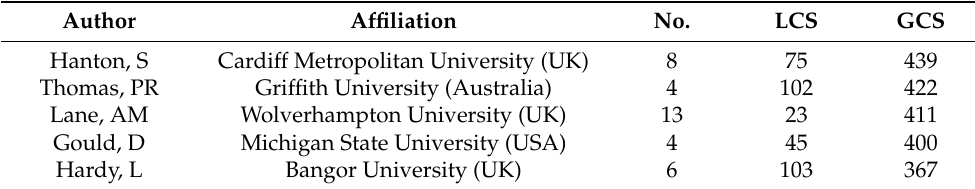
Table 2. Authors with the highest number of citations (>350).